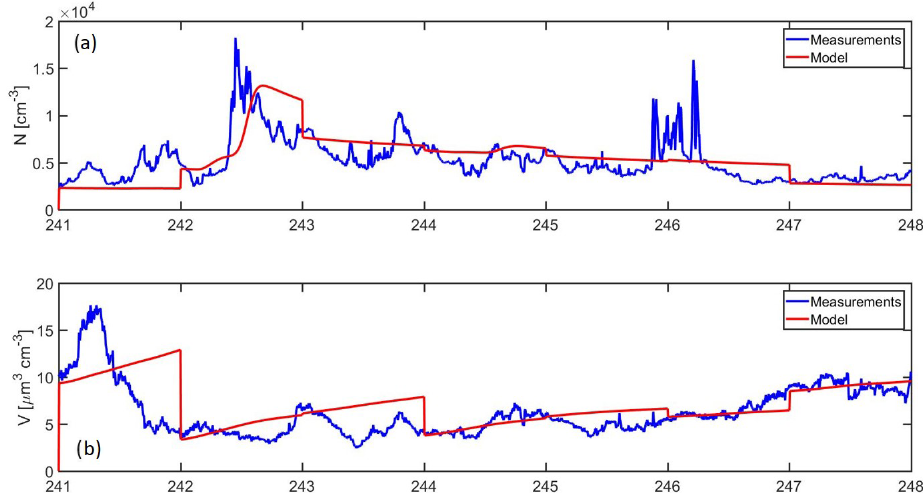
Figure 11. Simulations with the MALTE box with the adjusted parameters for the subtropical environment for the “event week” that NPF events were observed at Finokalia. Measured and modeled (a) total number concentration and (b) total volume concentration for the same period. The x axis in both figures gives the Julian day of 2012.